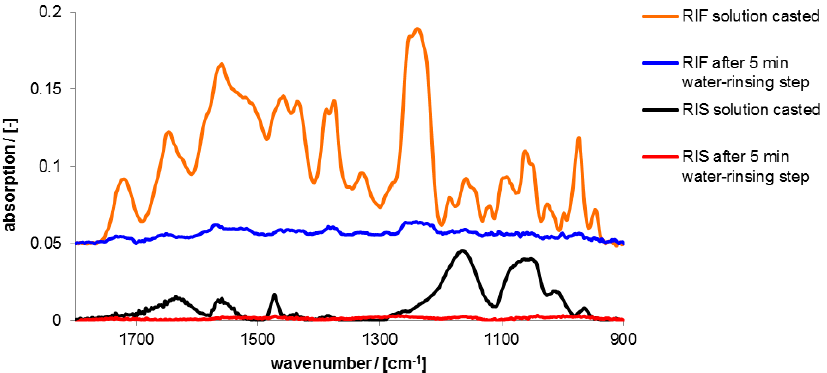
Figure 9. ATR-FTIR spectra of RIS and RIF films casted from 200 µL solutions (0.002 M) of the pure drug in the initial dry state and the dry state after 5 min rinsing in 2-(4-(2-Hydroxyethyl)-1- piperazinyl)-ethane sulfonic acid (HEPES) solution.